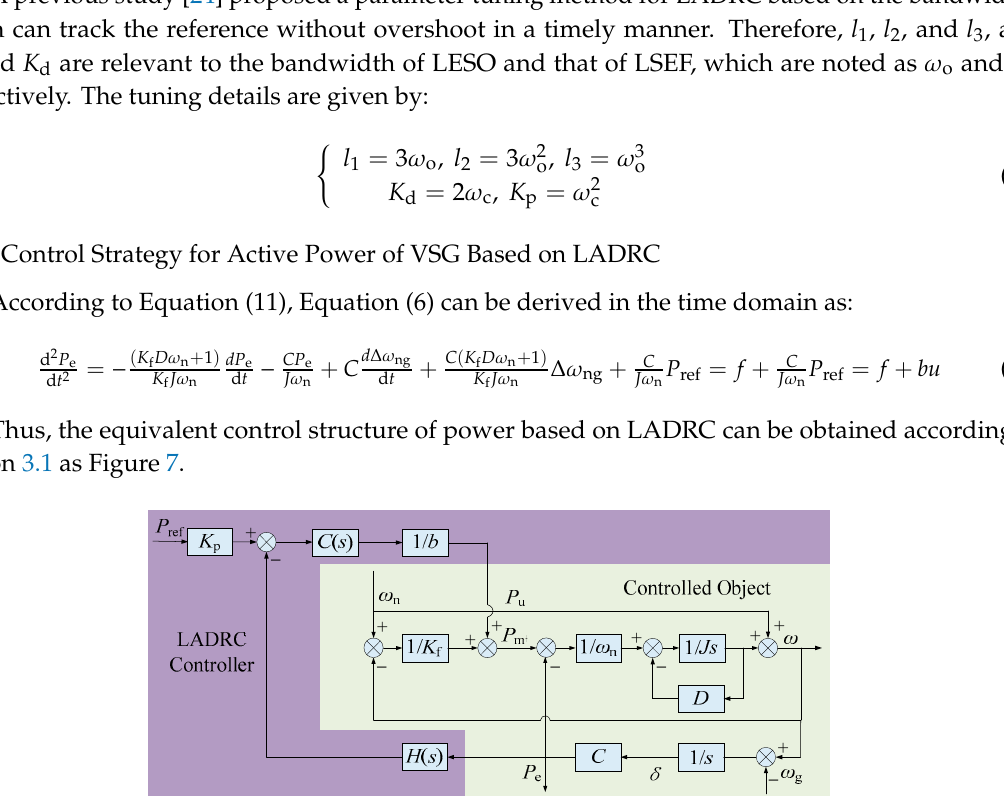
Figure 7. Control structure for power of VSG based on LADRC.